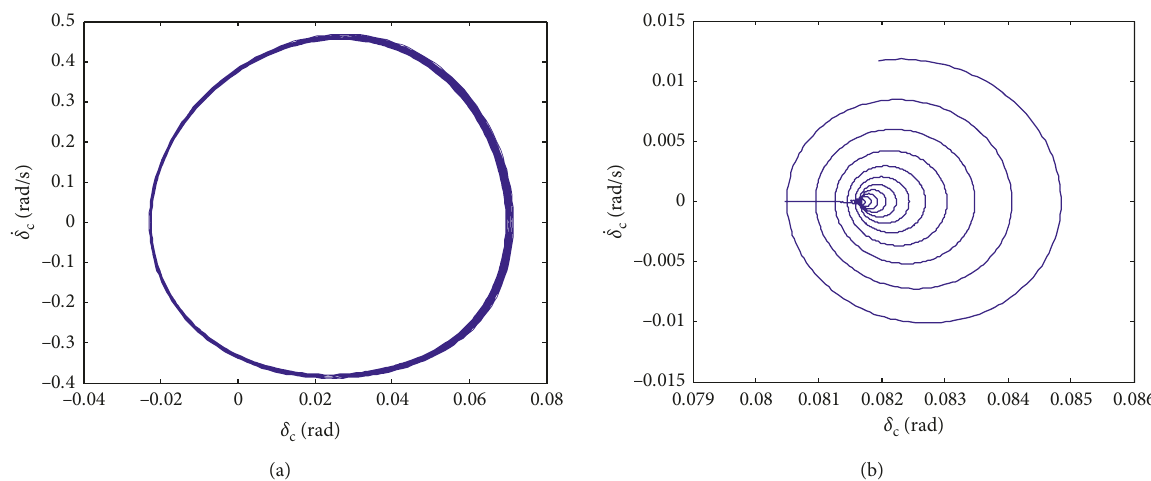
Figure 14: Phase diagrams of the compliance steering angle: (a) δ